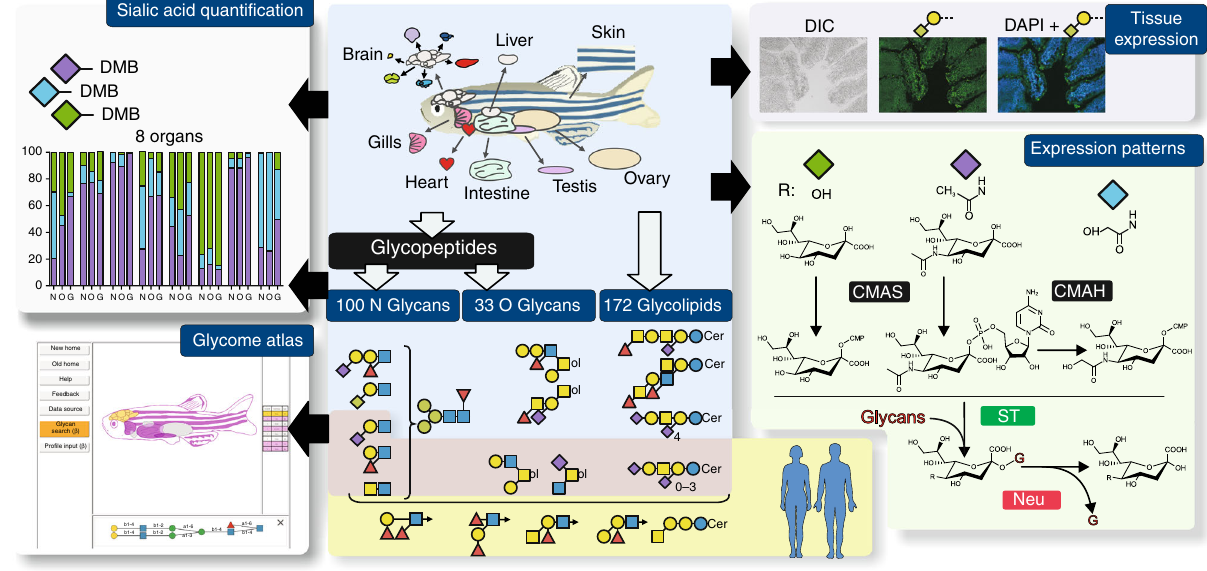
Fig. 1 Analytical work fl ow. NGs, OGs, and GSLs were puri fi ed from single batches of freshly dissected tissues before analysis of sialic acids, monosaccharides, and oligosaccharide sequences. Unique glycan structures identi fi ed and their spatial distribution were posited in an interactive database, Glycome Atlas (http://rings.t.soka.ac.jp/GlycomeAtlasV5/index.html), to provide easy access to the zebra fi sh glycome. In parallel, the expression pattern of enzymes involved in sialic acid metabolism was established, along with the tissue expression of speci fi c sialylated epitopes. Zebra fi sh glycome was shown to express many human-type glyco-epitopes, such as type-2 Gal β 1-4GlcNAc β 1-based sialyl LacNAc and Le x , simple sialylated O-glycans and major gangliosides, but differed by carrying additional glycosyl extensions and the absence of some blood group antigens (A, B), type-1 Gal β 1-3GlcNAc β 1-based epitopes, and globo-serie GSLs. CMAS CMP-Sia synthase, CMAH CMP-Sia hydroxylase, ST sialyltransferase, and Neu neuraminidase. Graphical representation is based on accepted conventions for glycans and monosaccharide nomenclature as follows: yellow circle, Gal; yellow square, GalNAc; blue circle, Glc; blue square, GlcNAc; green circle, Man; red triangle, Fuc; purple diamond, Neu5Ac; light blue diamond, Neu5Gc; green diamond, Kdn 77,78 . The interglycosidic bonds between monosaccharides of antennae are represented using the conventional positions as in |, C2 position; ∕ , C3 position; − ,